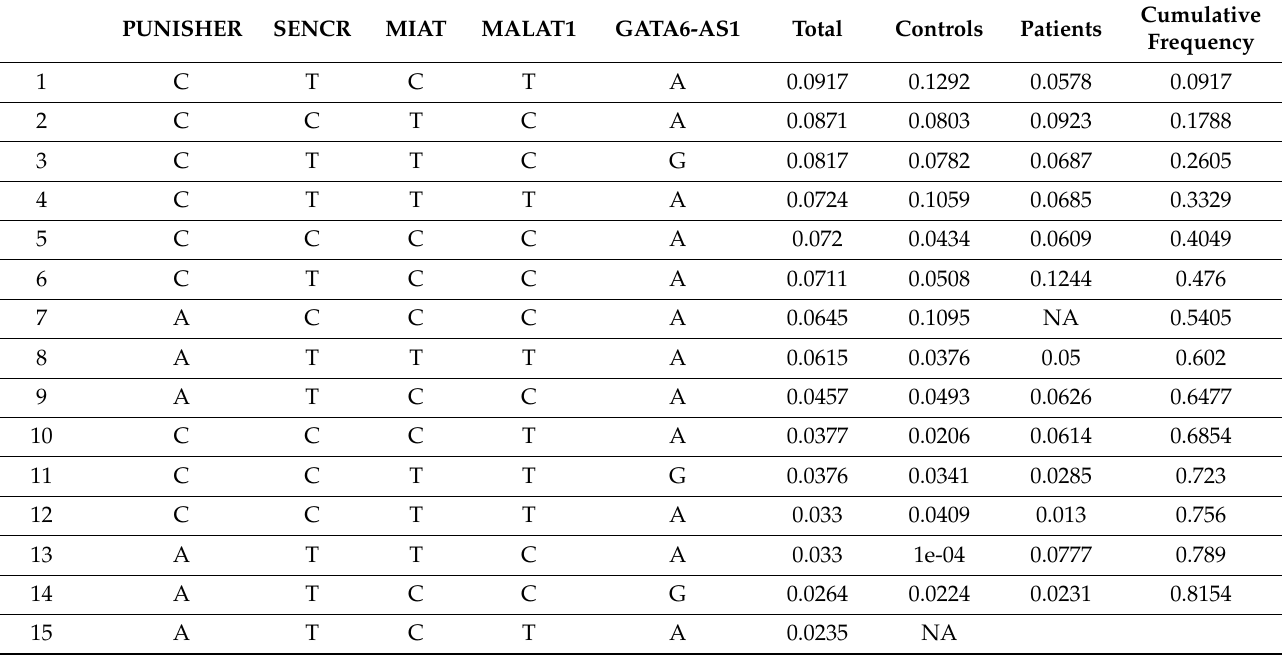
Table 4. Combined genotype association with disease risk.